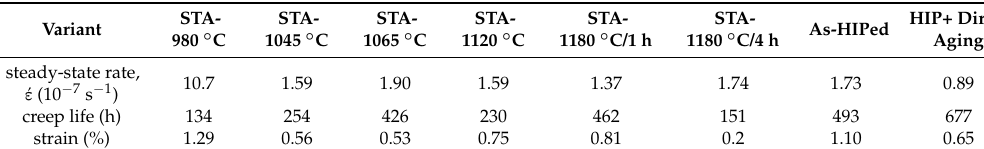
Figure 10. ( a ) Creep life, ( b ) creep rupture elongation, and ( c ) the minimum creep rate of heat-treated specimens under 650 °C and 550 MPa.